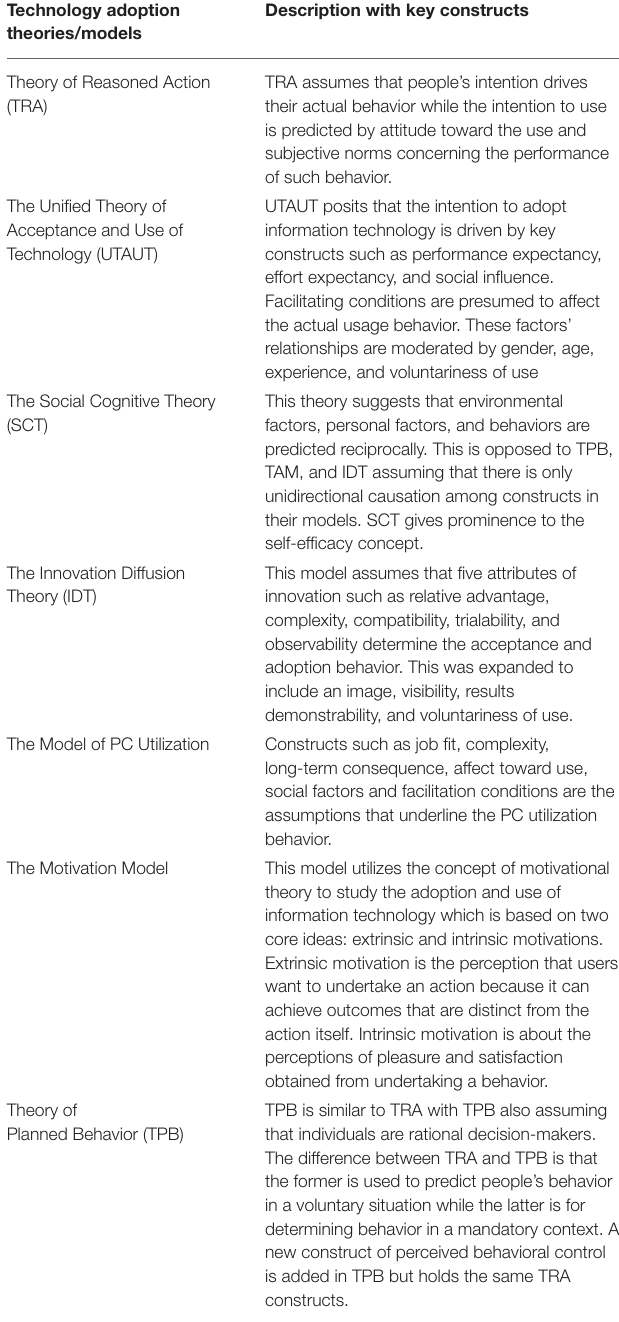
TABLE 2 | Technology adoption theories/models description with key